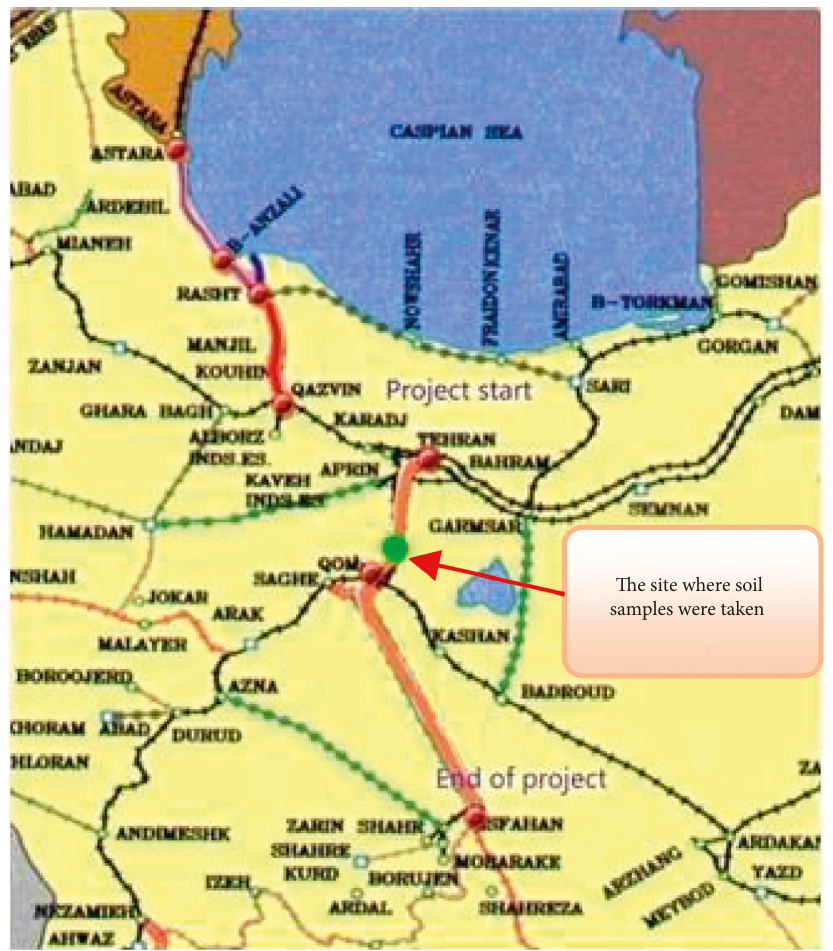
Figure 1: Geological location of the